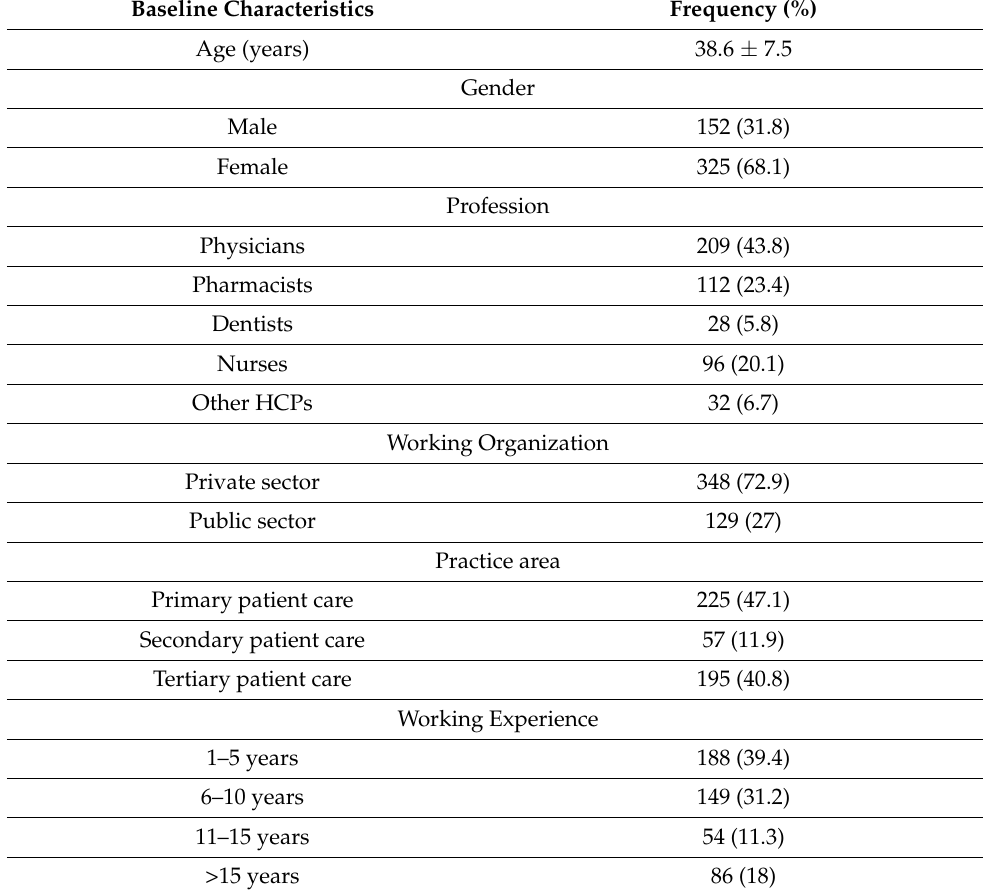
Table 1. Characteristics of study